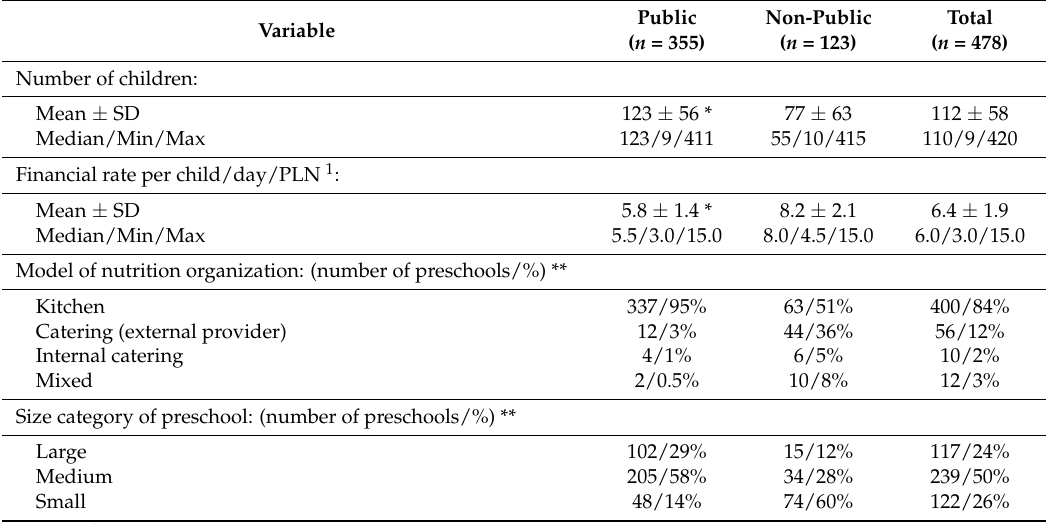
Table 1. General characteristics of preschools participating in nutritional education ( n = 478).